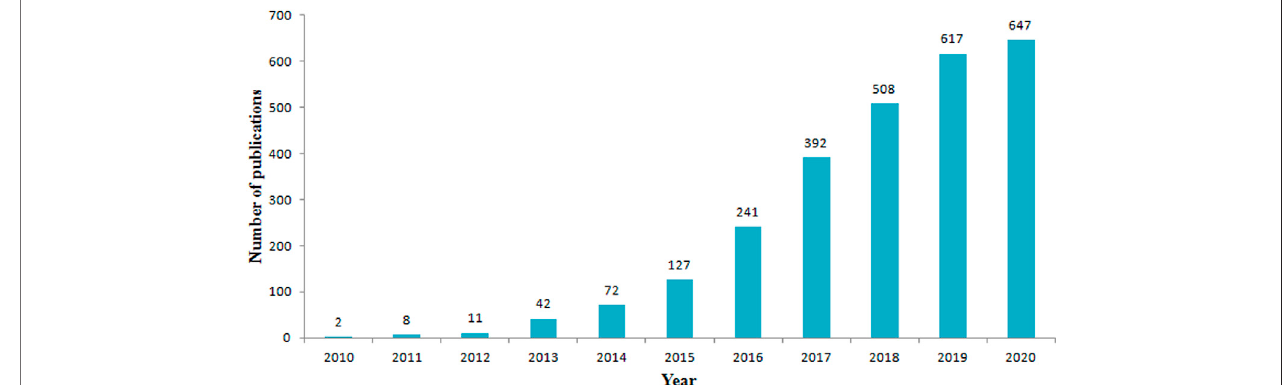
FIGURE 1 | The number of annual publications on the roles of lncRNAs in HCC development research from 2010 to 2020.